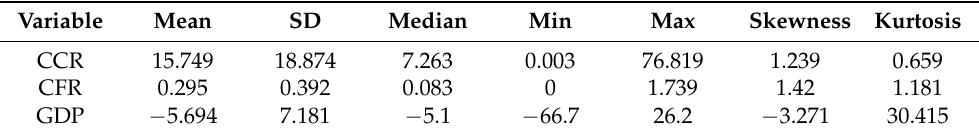
Table 3. Descriptive statistics.